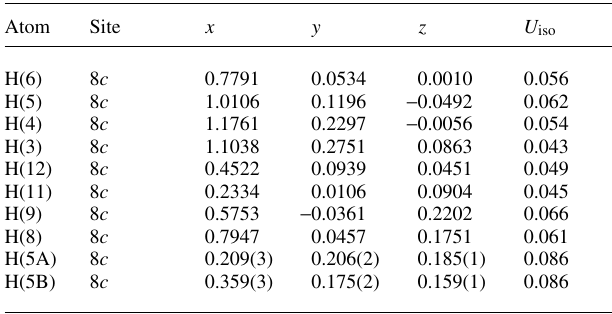
Table 2. Atomic coordinates and displacement parameters (in Å 2 )